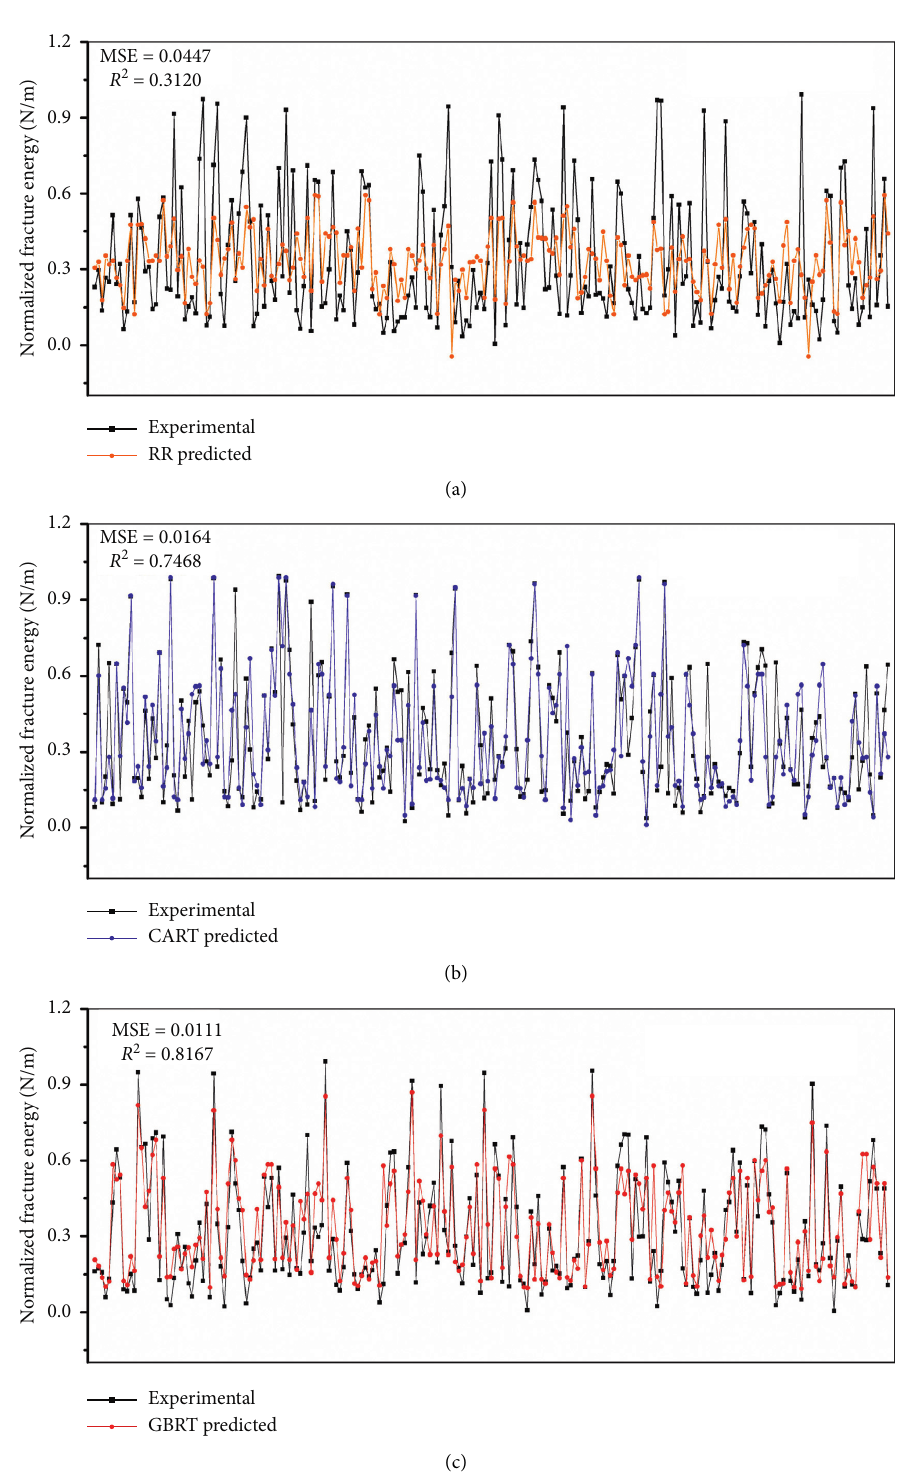
Figure 7: Comparison of the predicted and experimental values of concrete fracture energy: (a) RR; (b) CART; (c)